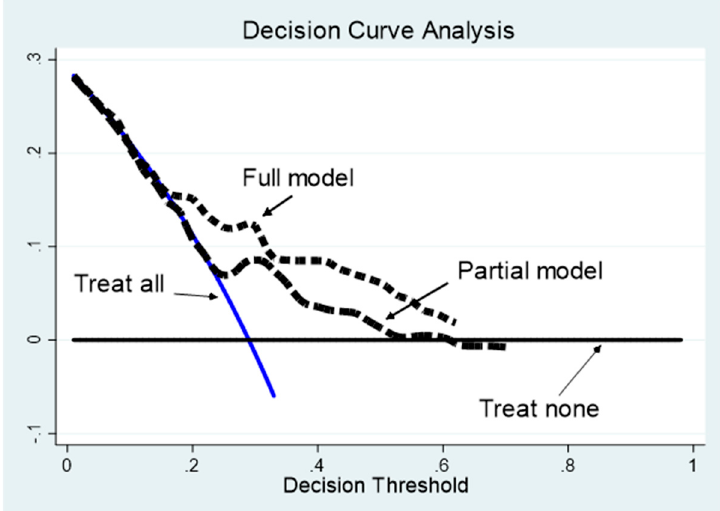
Figure 2. Decision curve analysis. The “treat none” (black continuous line) and “treat all’ (blue continuous line) curves are compared with the net benefit curves of the two Cox models: Full model (short dash black line) and partial model without MNA (long dash black line). The full model profile is higher than the partial model profile across the critical range of the decision threshold probabilities (20–60%). Both models show curves above that of the “treat none” and “treat all”